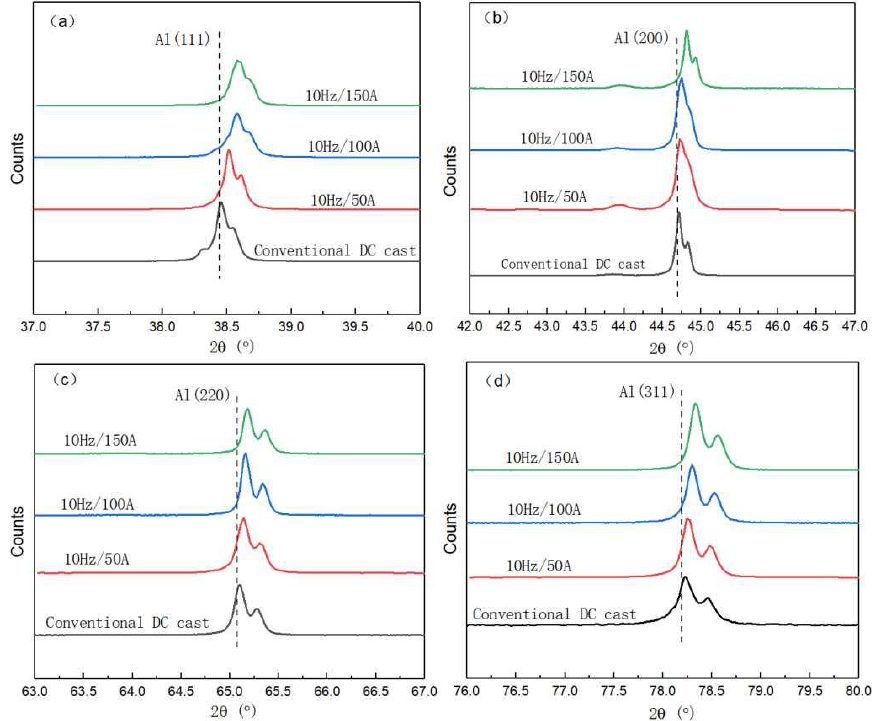
Figure 8. Di ff raction peaks of α (Al) at di ff erent crystal faces of 2A97 alloy DC casting and LFEC Figure 8. Diffraction peaks of α (Al) at different crystal faces of 2A97 alloy DC casting and LFEC ( a ) ( a ) (111); ( b ) (200); ( c ) (220); ( d ) (111); ( b ) (200); ( c ) (220); ( d ) (311).